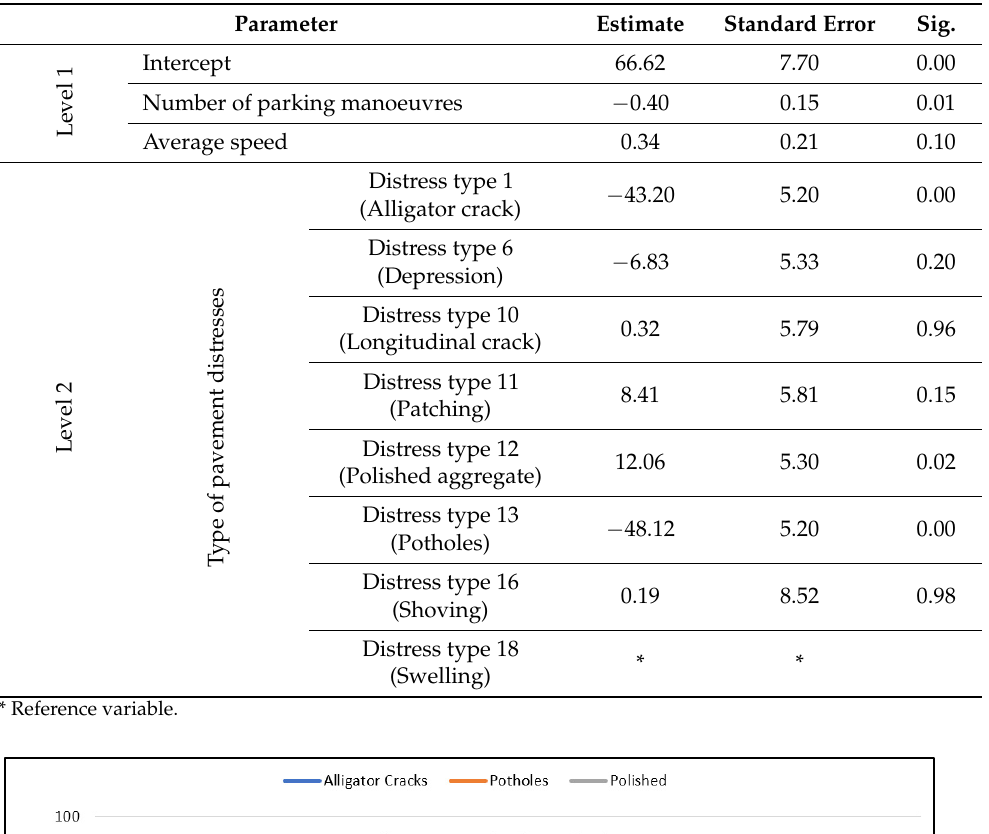
Table 5. Resulted fixed effect coefficient values.